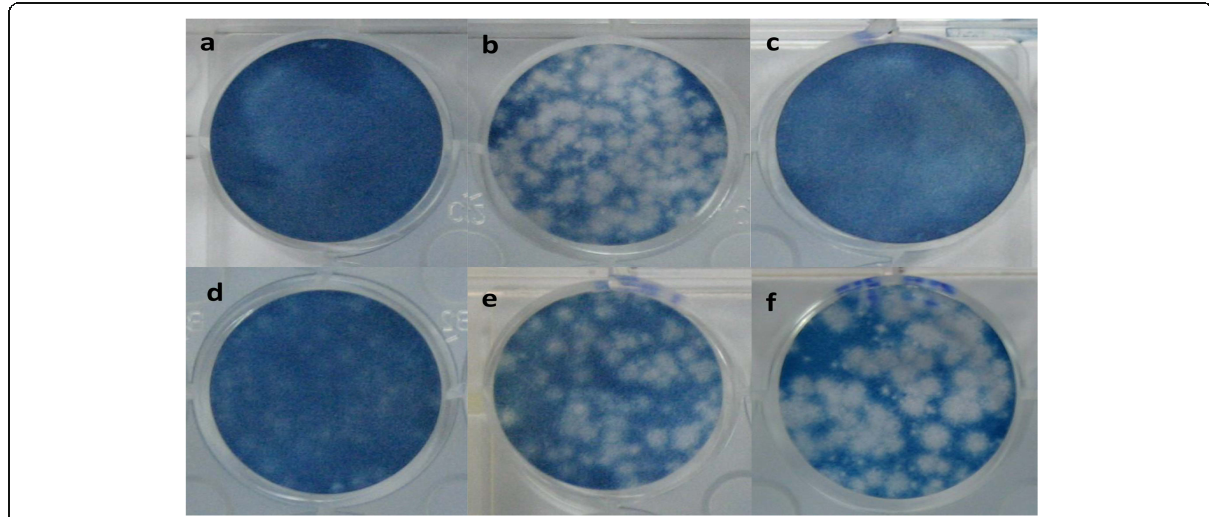
Fig. 1 Dose dependent inhibition of S. commune HAE by plaque reduction assay: a Uninfected Vero cells, b Vero cells infected with DENV2 (NGC strain) (80 – 100 PFU), c Infected cell after treated with Ribavirin (250 μ g/ml), d , e and f Infected cell after treated with S. commune HAE (2500 μ g/